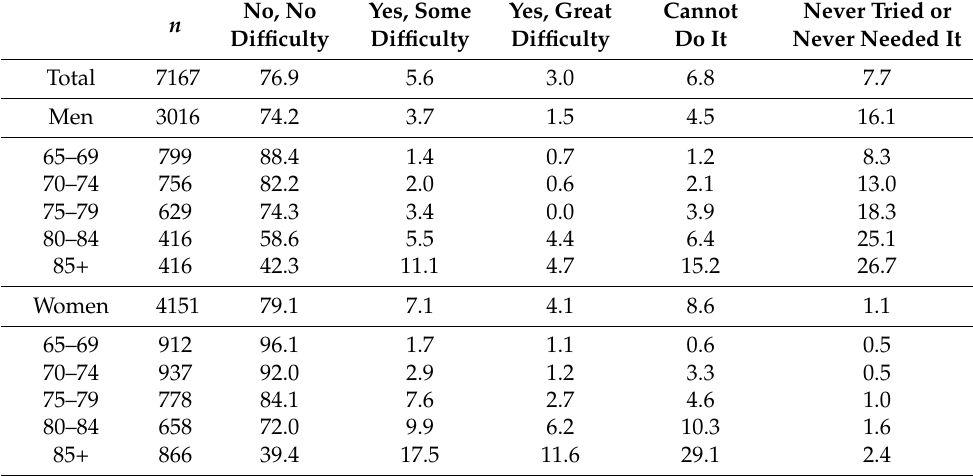
Figure 3. Shopping Difficulty (%) in the elderly population. Source: compiled by the authors based on data from EHSS, 2020.